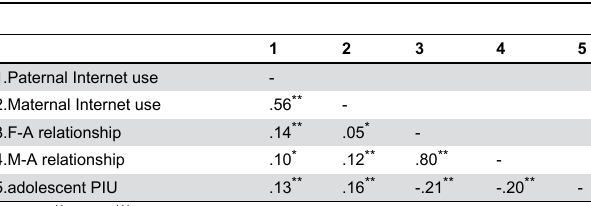
Table 3. Correlating Analysis of Perceived Parental Variables and Adolescents’ PIU.